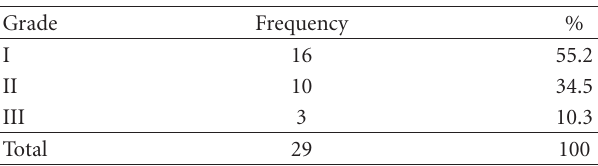
Table 3: Histological grade of the invasive epithelial component ( n = 29).